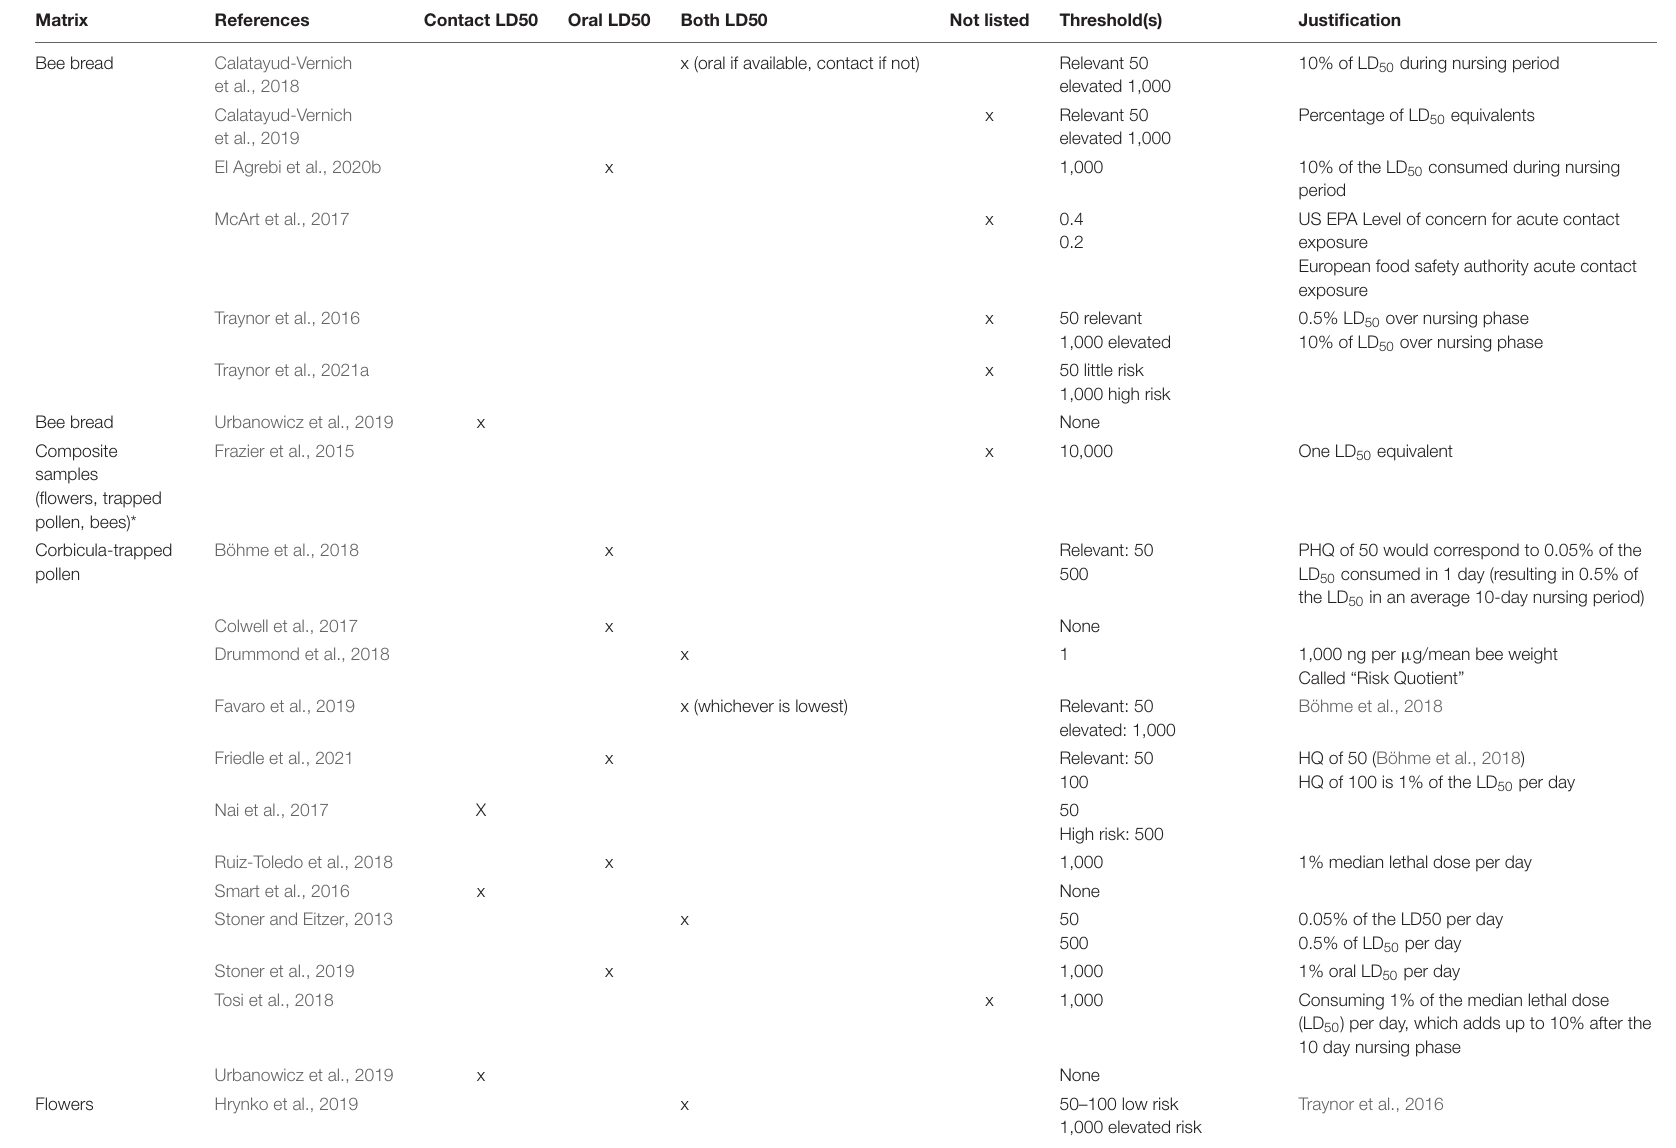
TABLE 1 | A table displaying the contact or oral LD50 value, thresholds associated, and justifications for the thresholds, if provided.